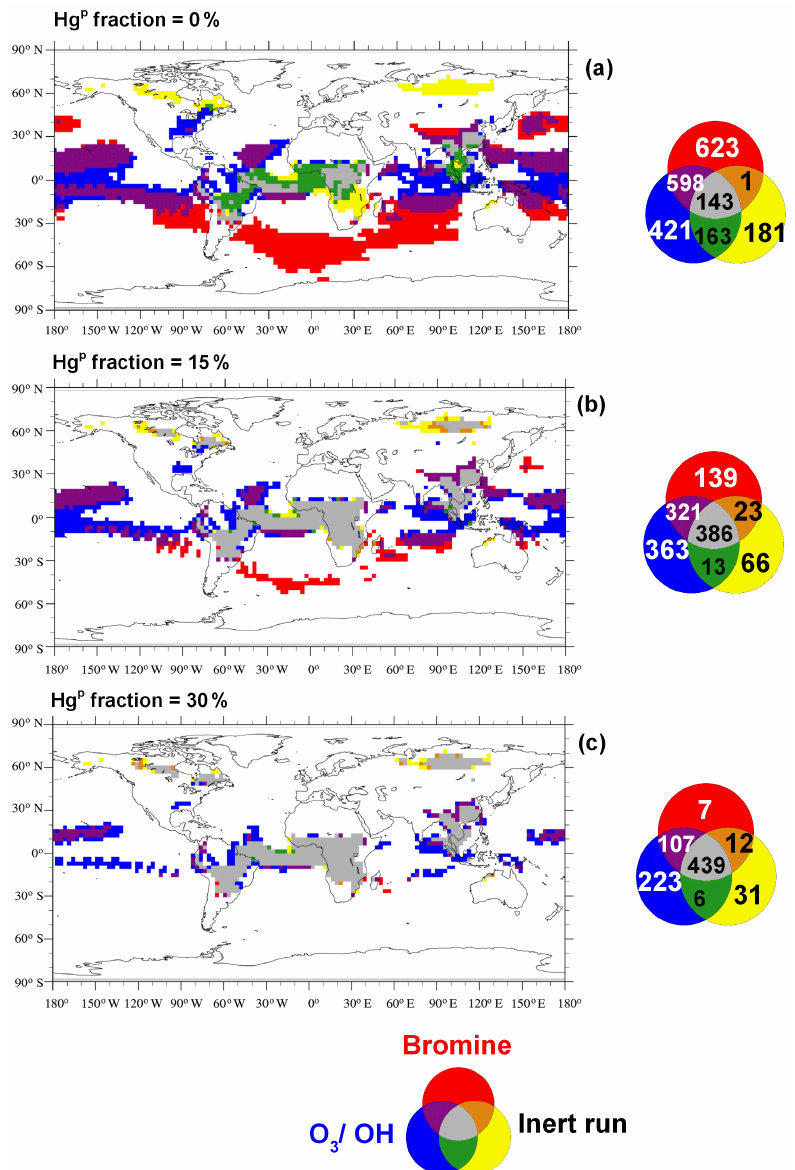
Figure 8. Agreement maps, under three different speciation scenarios, 0% (a) , 15% (b) and 30% (c) Hg P , of high Hg deposition model cells obtained considering only BB and using the O 3 / OH, the Br oxidation mechanisms, and a sensitivity run where all Hg BB emissions were considered inert (i.e. all Hg P ). The deposition field from for this “inert” run was retained under the three different speciation scenarios. The maps show the areas where deposition is greater than µ + σ